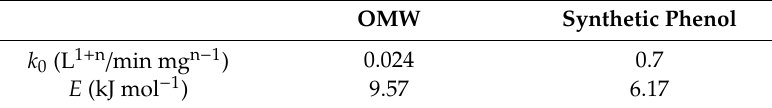
Table 1. Regressed parameters of photocatalysis kinetic Table 1: Regressed parameters of photocatalysis kinetic modelling